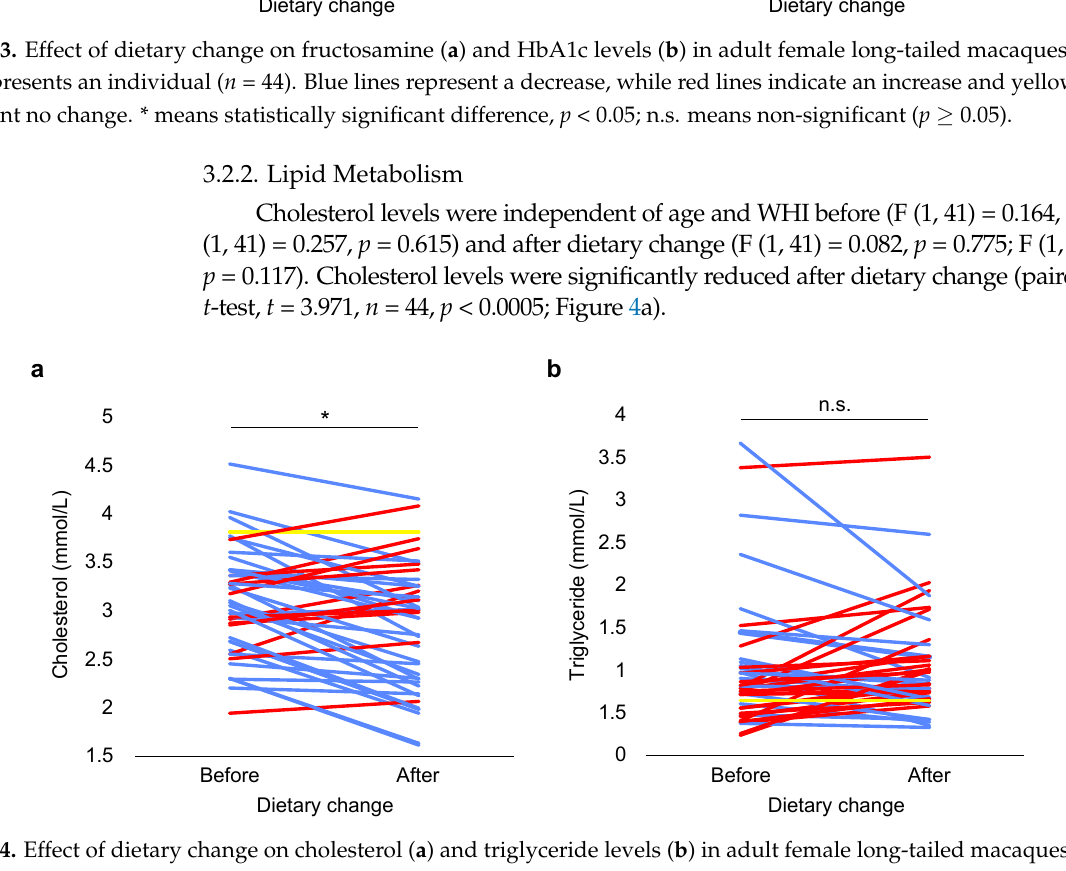
Figure 3. Effect of dietary change on fructosamine ( a ) and HbA1c levels ( b ) in adult female long-tailed macaques. Each line represents an individual ( n = 44). Blue lines represent a decrease, while red lines indicate an increase and yellow lines represent no change. * means statistically significant difference, p < 0.05; n.s. means non-significant ( p ≥ 0.05).